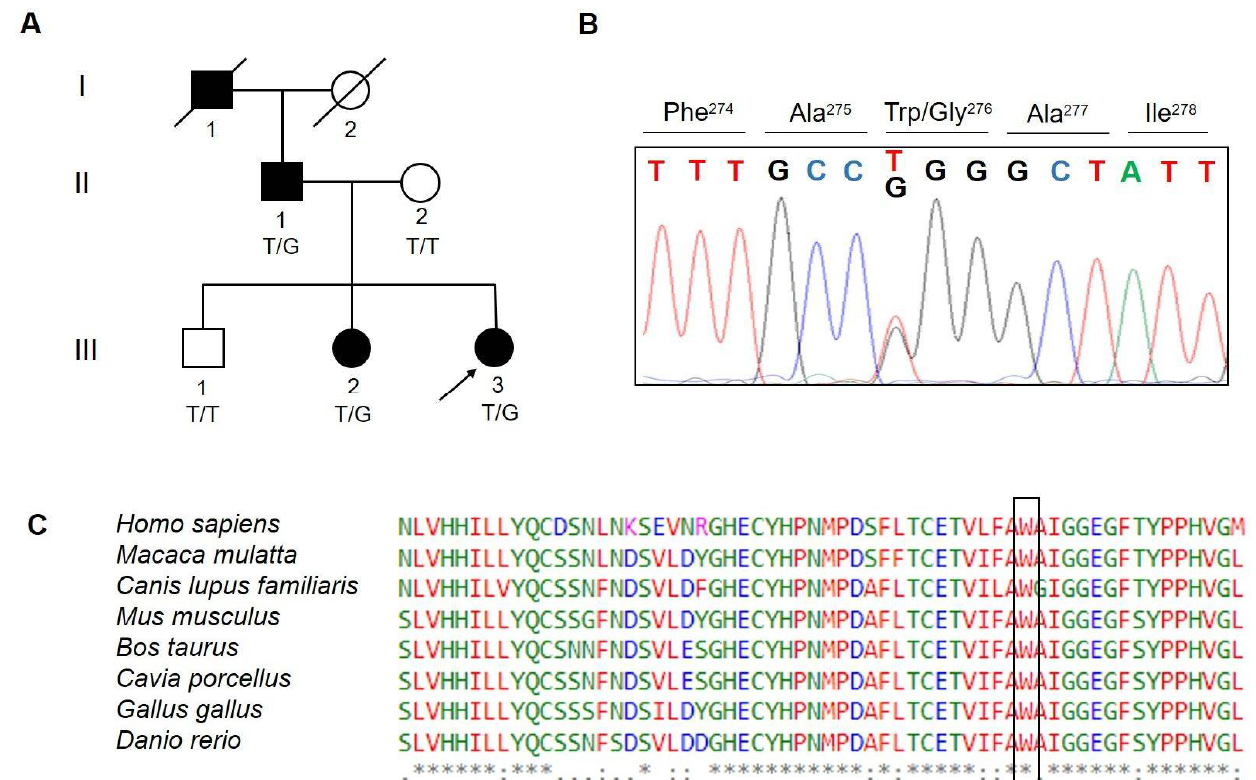
Figure 1. ( A ) Family pedigree of the proband showing the identified variant. The arrow points to the proband. Genotypes for available individuals are shown as T/T, wild-type (WT) genotype and T/G, heterozygous genotype; ( B ) sequencing chromatogram including the identified p.(Trp276Gly) variant is shown; ( C ) multiple alignments using ClustalW and amino acid conservation of MOXD1 p.(Trp276Gly) across several species. Letters in the box denote amino acids substituted. An asterisk denotes conserved amino acid.